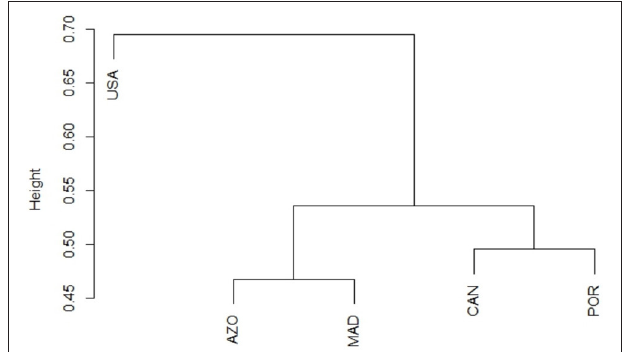
FIGURE 2 | Similarity between biogeographic regions by cluster analysis; y-axis represents binary distances. USA, United States east coast; AZO, Azores; MAD, Madeira; CAN, Canaries; POR, Portugal continental shelf.